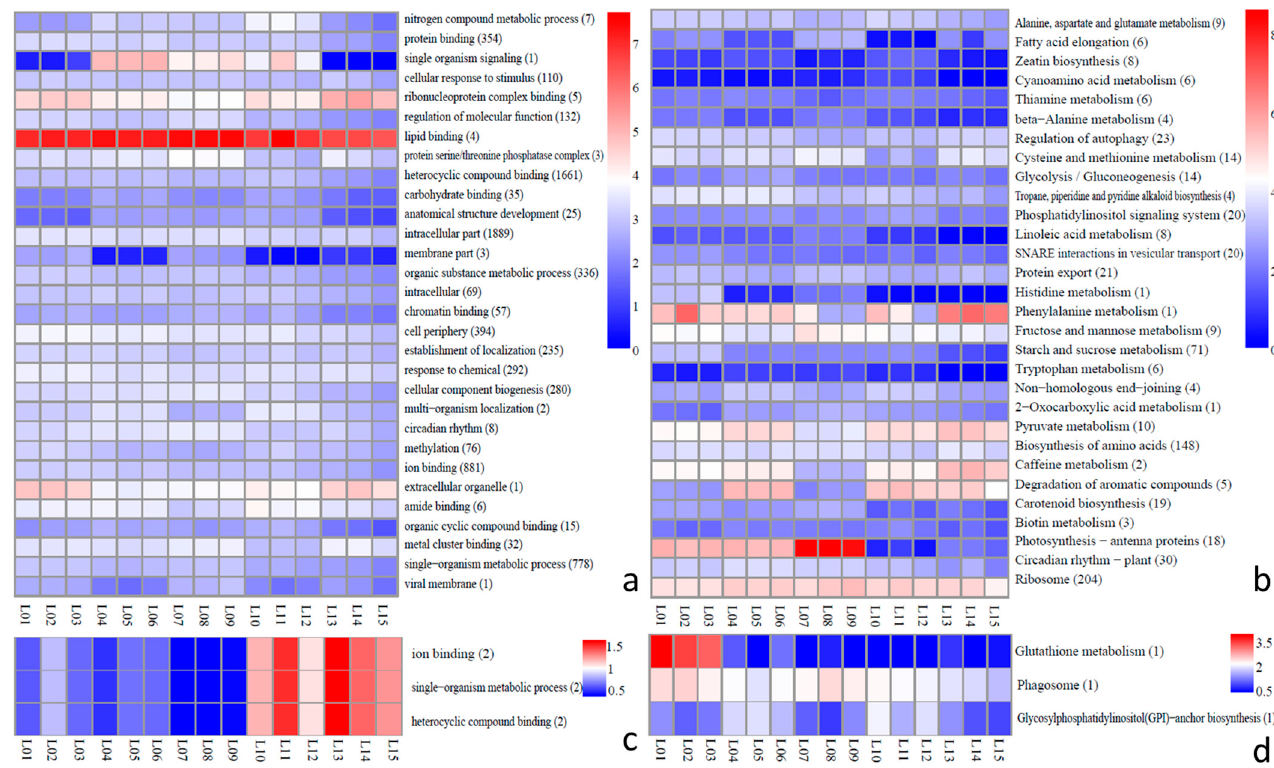
Figure 4. GO term and KEGG pathway enrichment analysis of all differentially expressed of lncRNAs in five tissues (L1–L3: flowers; L4–L6: phloem; L7–L9: leaves; L10–L12: roots; L13–L15: fruit). ( a ) GO term enrichment analysis of all differentially expressed cis-target genes of lncRNAs. ( b ) KEGG pathway enrichment analysis of all differentially expressed cis-target genes of lncRNAs. ( c ) GO term enrichment analysis of all differentially expressed trans-target genes of lncRNAs. ( d ) KEGG pathway enrichment analysis of all differentially expressed trans-target genes of lncRNAs.